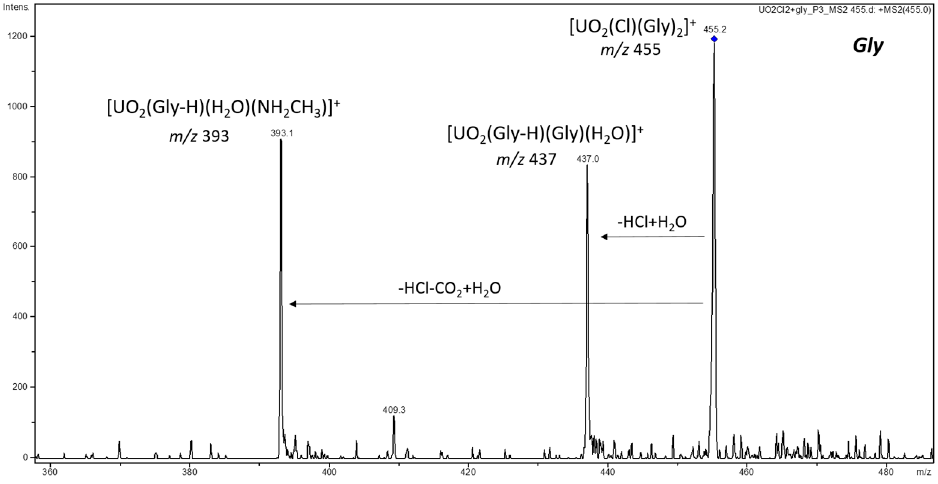
Figure 4. CID mass spectrum of [UO 2 (Cl)(Gly) 2 ] + .